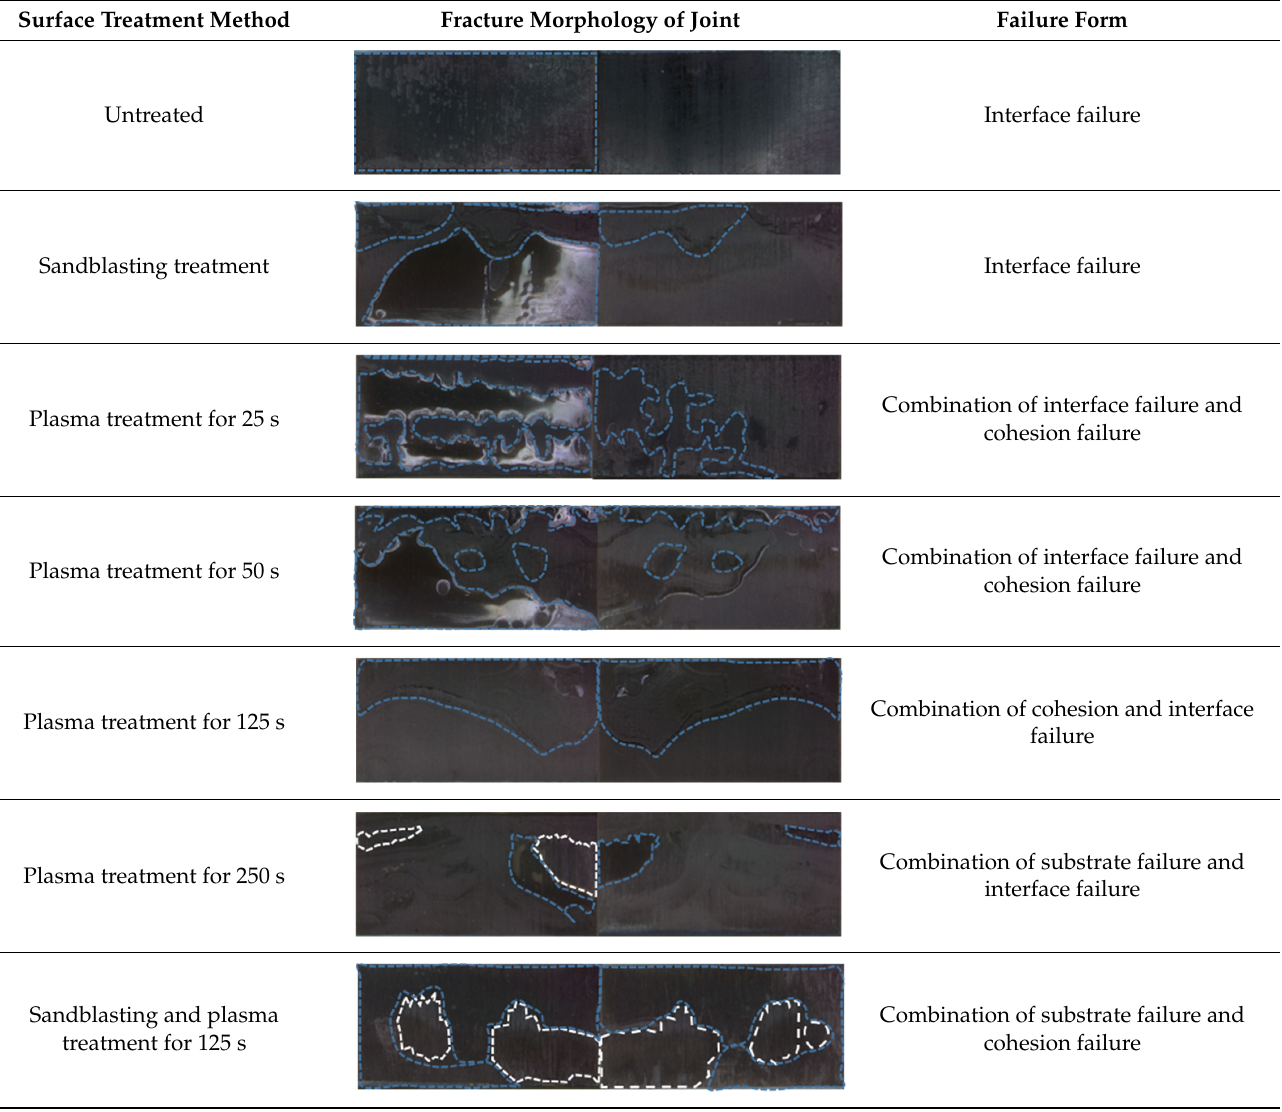
shown in Table 7. Table 7. Schematic diagram of failure types of single-lap joints.